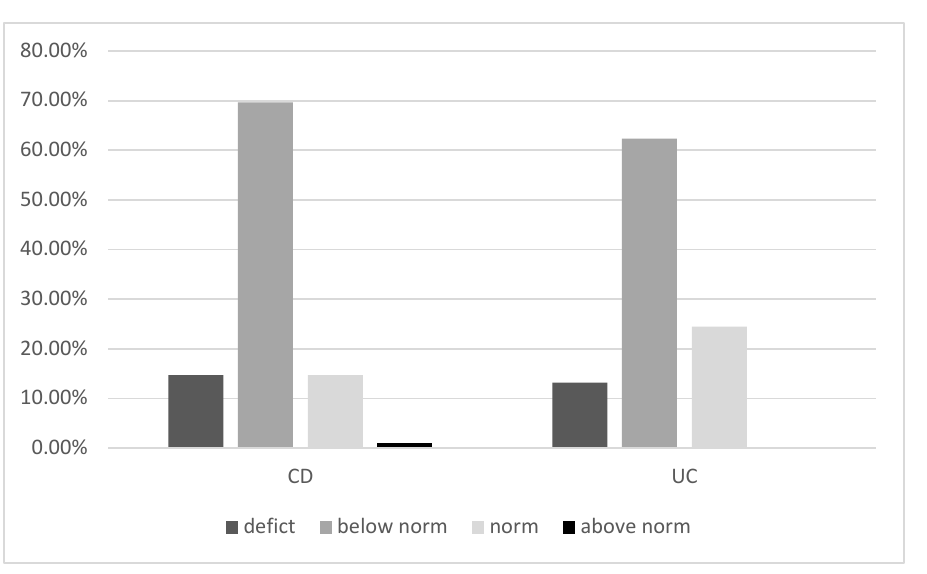
Figure 1. Vitamin D concentration in patients with CD and UC ( p = 0.437). Abbreviations: CD: Crohn’s disease, UC: ulcerative colitis.